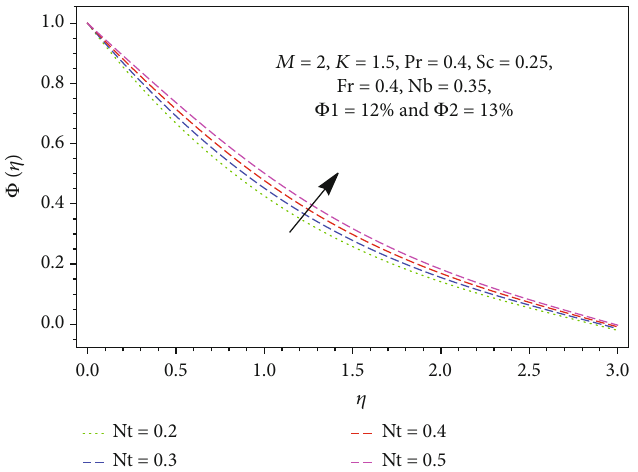
Figure 11: Impact of thermophoresis parameter Nt on the concentration pro fi le f ð η Þ